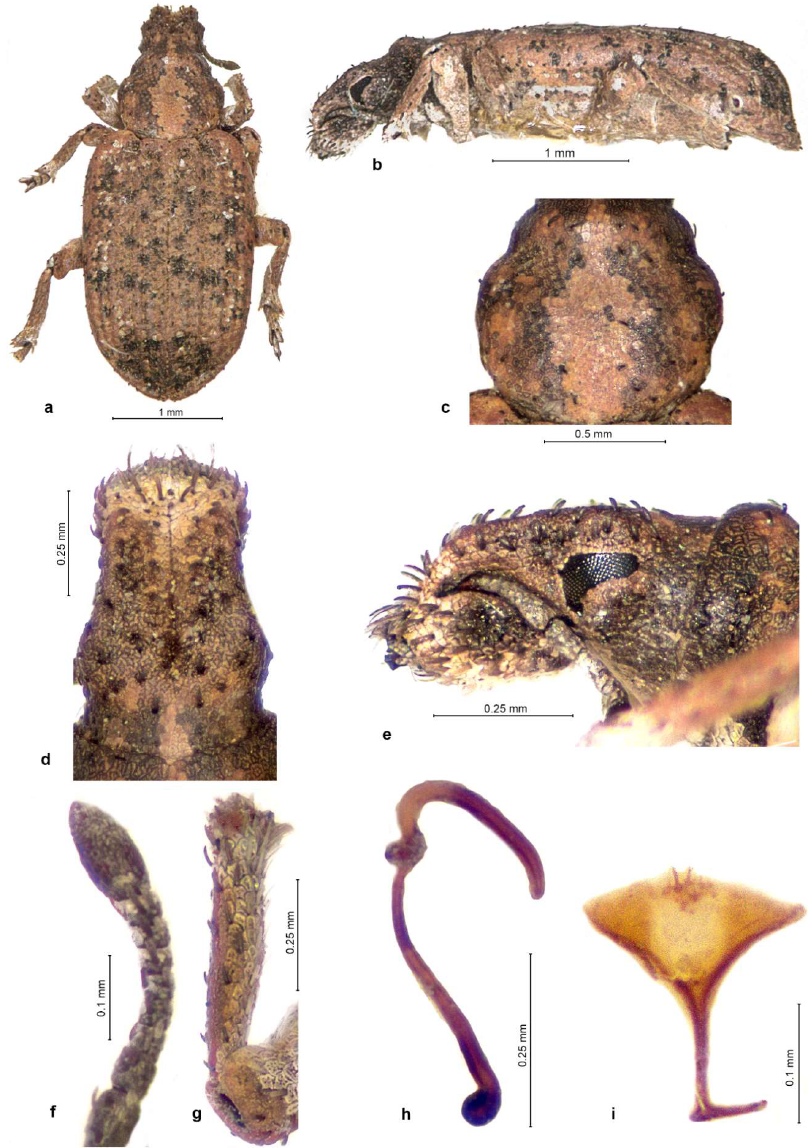
Figure 1. Philetaerobius nidicola Marshall. Lectotype ♂ —dorsal habitus ( a ); left lateral habitus ( b ); pronotum, dorsal view ( c ); head, dorsal view ( d ); head, lateral view ( e ); right antenna, dorsal view ( f ); left protibia, dorsal view ( g ). Paralectotype ♀ —spermatheca ( h ); sternite VIII ( i ).